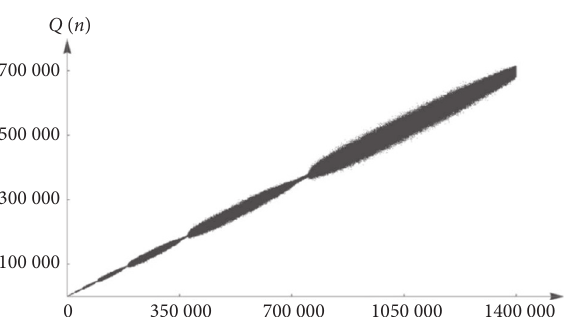
Figure 1: Hofstadter Q -sequence for ( n ) from 1 to 1,500,000.